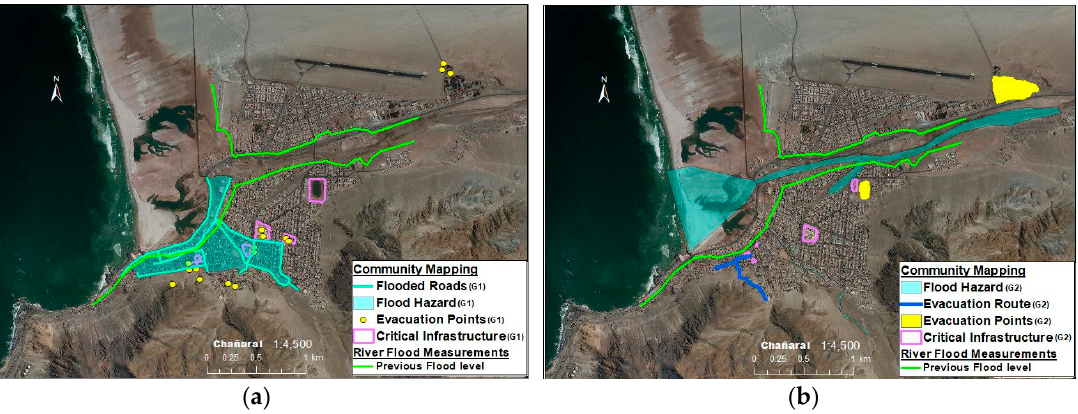
Figure 15. Extent of the floods and perceptions: ( a ) Group 1, ( b ) Group 2. Note that the location of critical infrastructure is also shown.